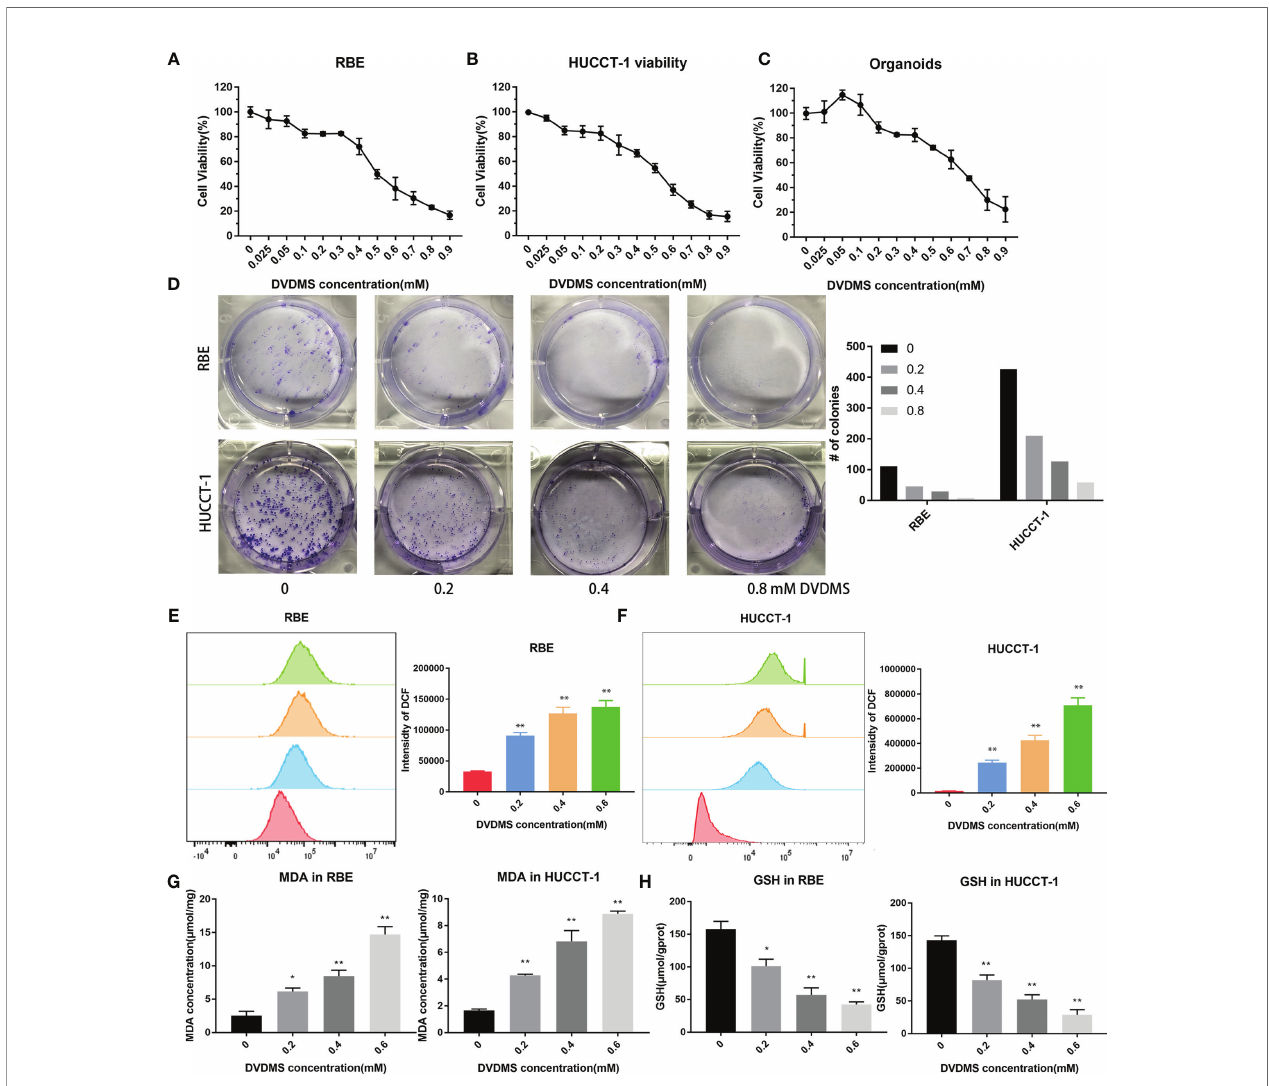
FIGURE 8 | PDT inhibited the viability of CCA, increased the content of ROS and MDA, and decreased the concentration of GSH. (A – C) Celltiter blue was used to detect the viability changes of RBE, HUCCT-1, and organoids after different concentrations of DVDMS-PDT (0 – 0.9 mM, 10 J/cm 2 ). (D) The images of colony formation and histograms show that different concentrations of DVDMS-PDT inhibited the proliferation in RBE and HUCCT-1. (E, F) Flow cytometry and histograms show that ROS levels upregulated in RBE and HUCCT-1 cells after DVDMS-PDT (0 – 0.6 mM, 10 J/cm 2 ) treatment. (G) MDA increased and (H) GSH decreased after DVDMS-PDT (0 – 0.6 mM, 10 J/cm 2 ) treatment, respectively. *p < 0.01, **p <